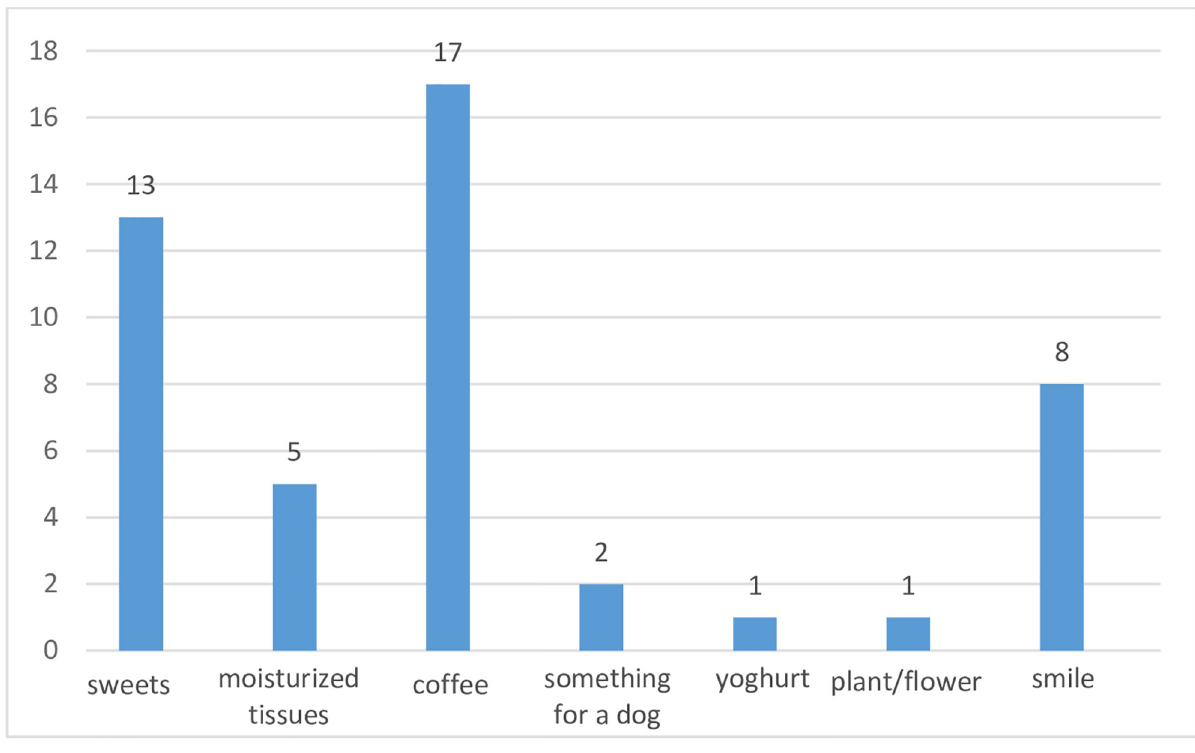
Fig 4. Goods expected in exchange for medicines.